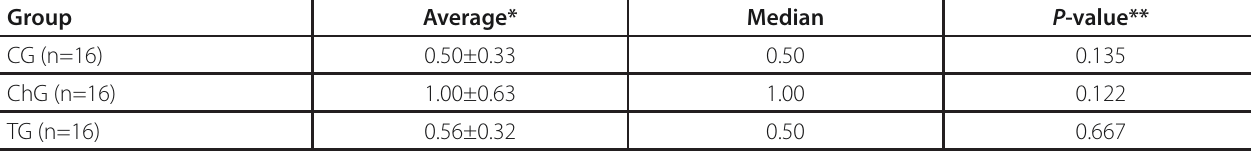
Table 3 . Classification of adhesions according to the classification by Knightly et al. [4] . Group